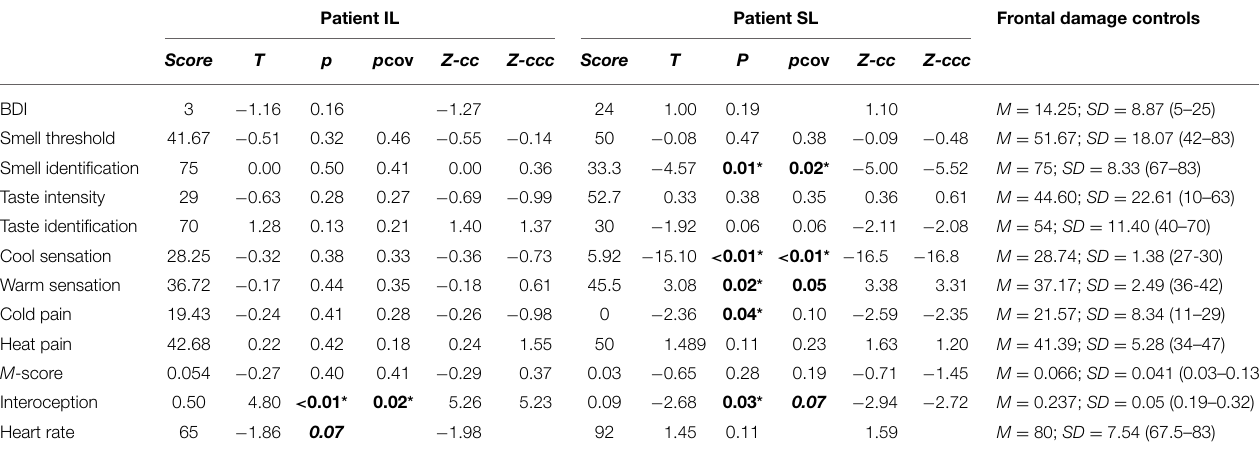
TABLE 3 | Results of comparing patient IL and SL with frontal damage patients.